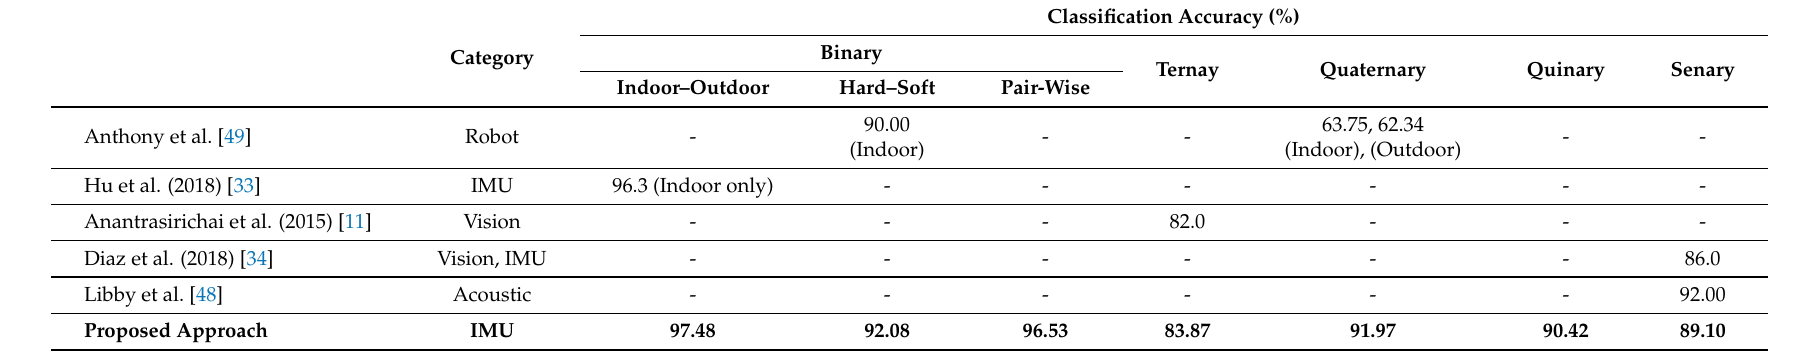
Table 8. Comparison of classification rate with existing approaches in